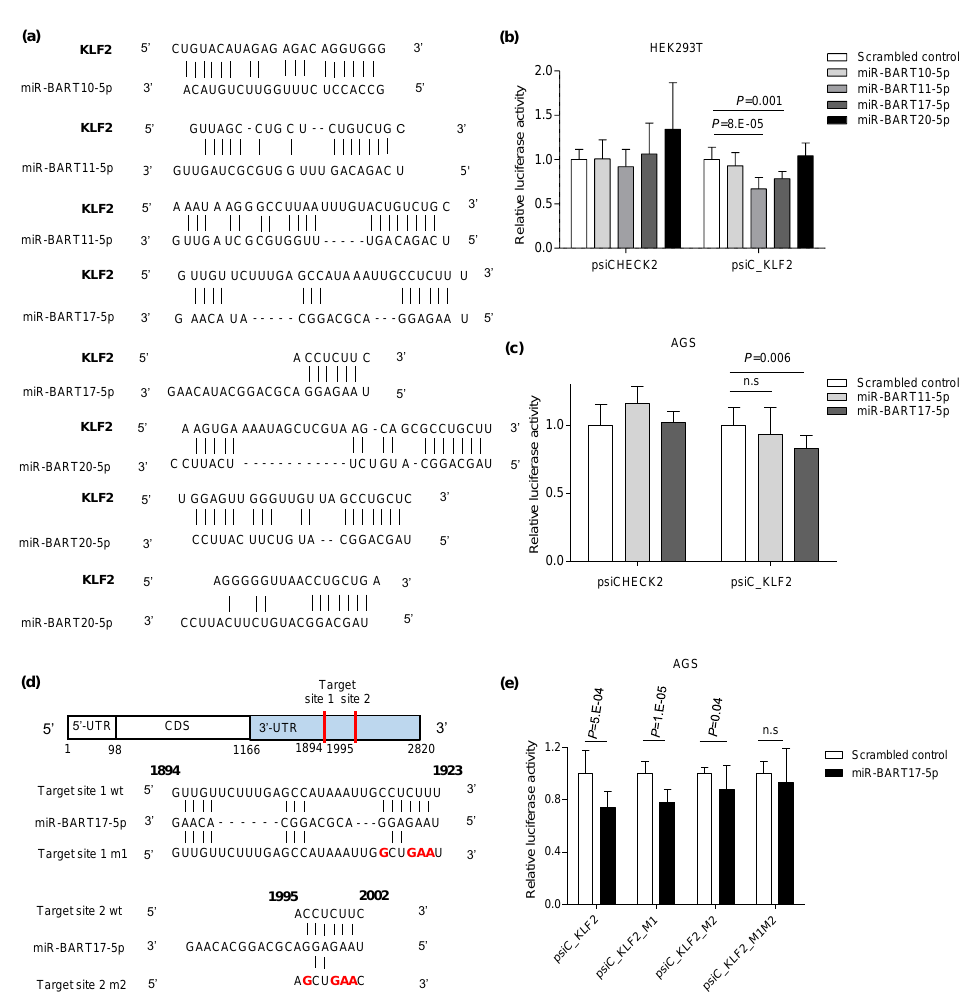
Figure 2. Screening of EBV microRNA that targets KLF2 . ( a ) Seed matches between four BART miRNAs and the 3 (cid:48) UTR of KLF2 . ( b,c ) psiC_KLF2 and each BART miRNA were co-transfected into HEK293T cells ( b ) and AGS cells ( c ). Luciferase reporter assays were measured 48 h after transfection. Three independent experiments were conducted to confirm reproducibility. Luciferase activity was normalized using internal firefly luciferase activity. The luciferase activity of the cells transfected with each BART miRNA is expressed as a ratio to the luciferase activity obtained from the scrambled control transfected cells. Error bars indicate SDs. ( d ) Schematic drawing shows the location of the predicted target sites 1 and 2 for miR-BART17-5p on the 3 (cid:48) UTR of KLF2 mRNA (upper panel). Two sites in the 3 (cid:48) UTR of KLF2 that seed match with miR-BART17-5p were mutated individually or together, and the mutated sequences are shown in red (lower panel). ( e ) Luciferase assay was carried out using AGS cells co-transfected with psiC_KLF2 (wildtype or mutants) and 30 nM miR-BART17-5p. Each value represents the mean ± SD in four independent experiments. Abbreviation: n.s, not